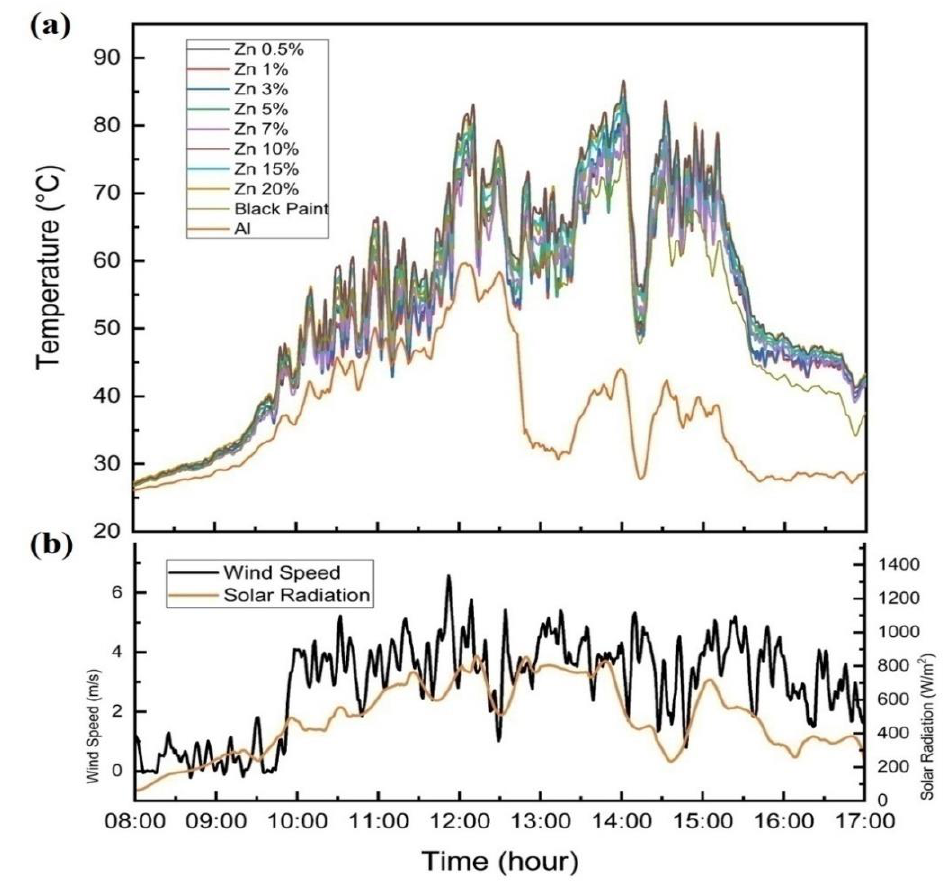
Figure 7. ( a ) Outdoor Experiment Data of absorber plates associated with ( b ) weather condition at